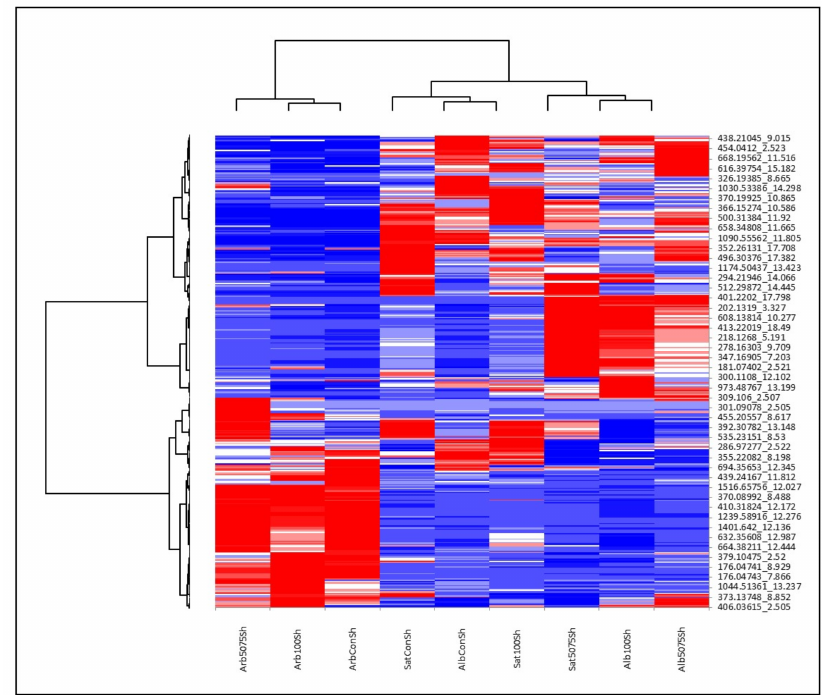
Figure 5. Heat map analysis of UHPLC-HRMS/MS metabolomics in shoots. The row represents each metabolite, and the column represent each treatment. Metabolites significantly decreased are displayed in red, while metabolites significantly increased are displayed in